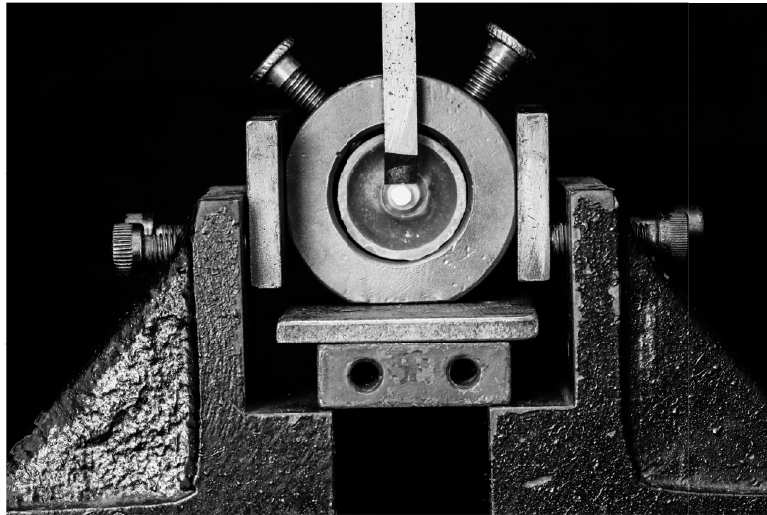
Figure 1. Shear bond strength